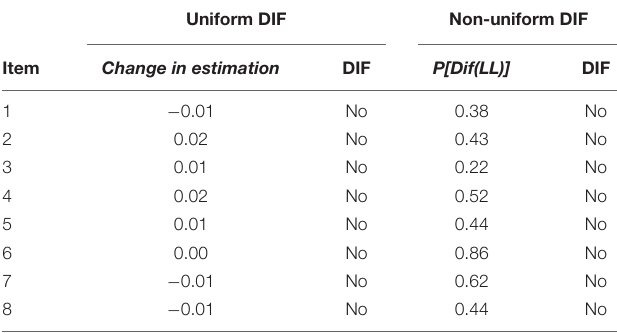
TABLE 4 | Differential item functioning (DIF) for